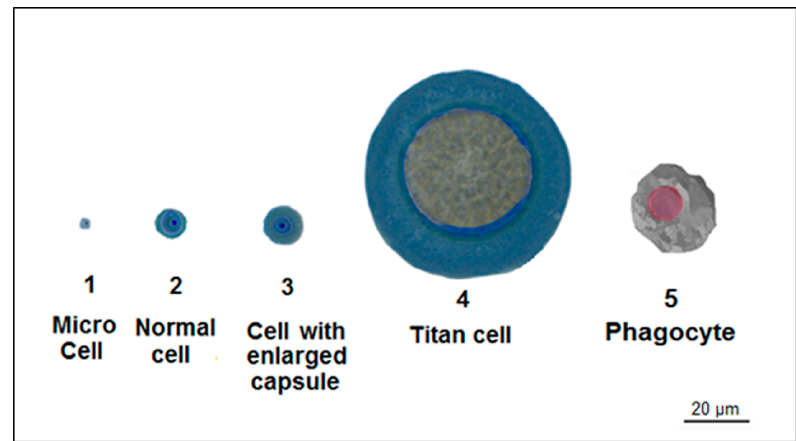
Figure 3. Different cell populations found in lungs of infected mice with C. neofromans . Yeasts with different capsule sizes, microforms, regular size cells, and titan cells, which are larger than phagocytes, are present during lung infection in mice.